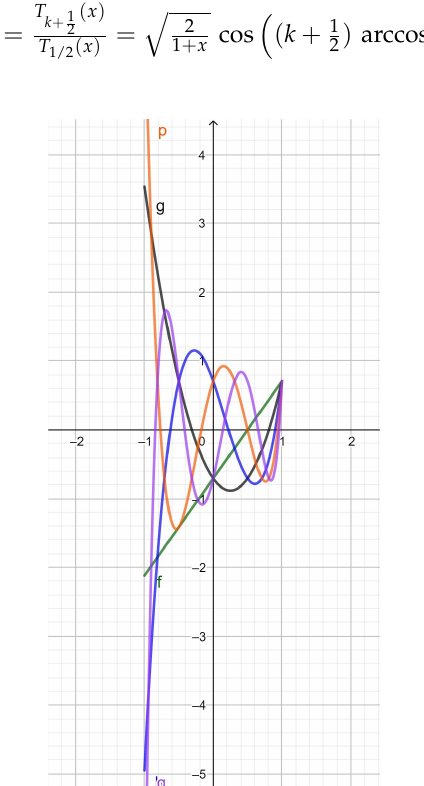
Figure 3. V k ( x ) , k = 1,2,3,4,5. 1, green; 2, red; 3, blue; 4, orange; 5,